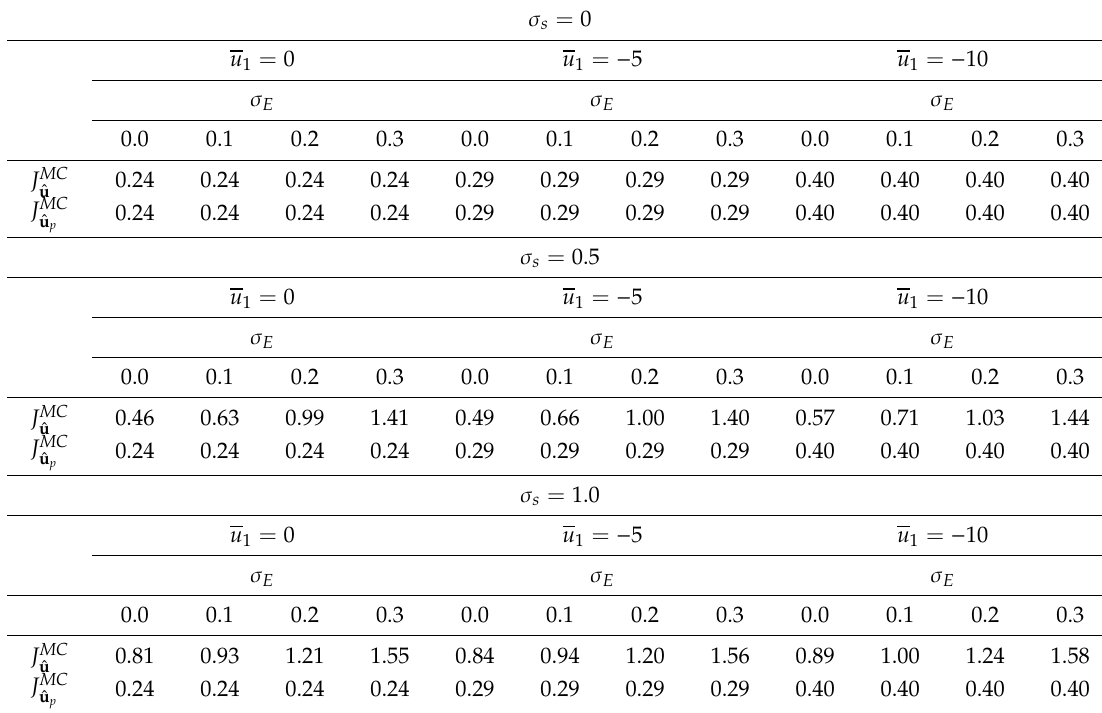
and J MC obtained with the Monte Carlo (MC) ˆ u ˆ u p